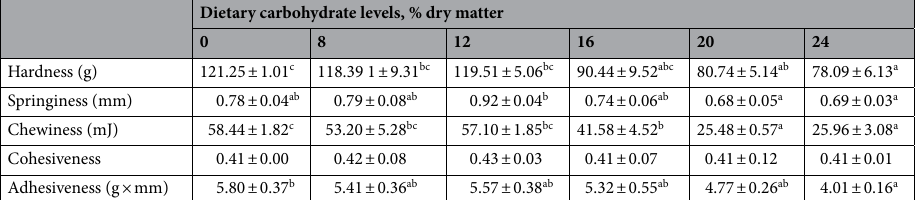
Table 2. The muscle texture of olive flounder after a 10-week feeding trial. All data were expressed as mean ± SE. Mean values within the same row with different superscripts are significantly different ( P < 0.05; Tukey’s test).